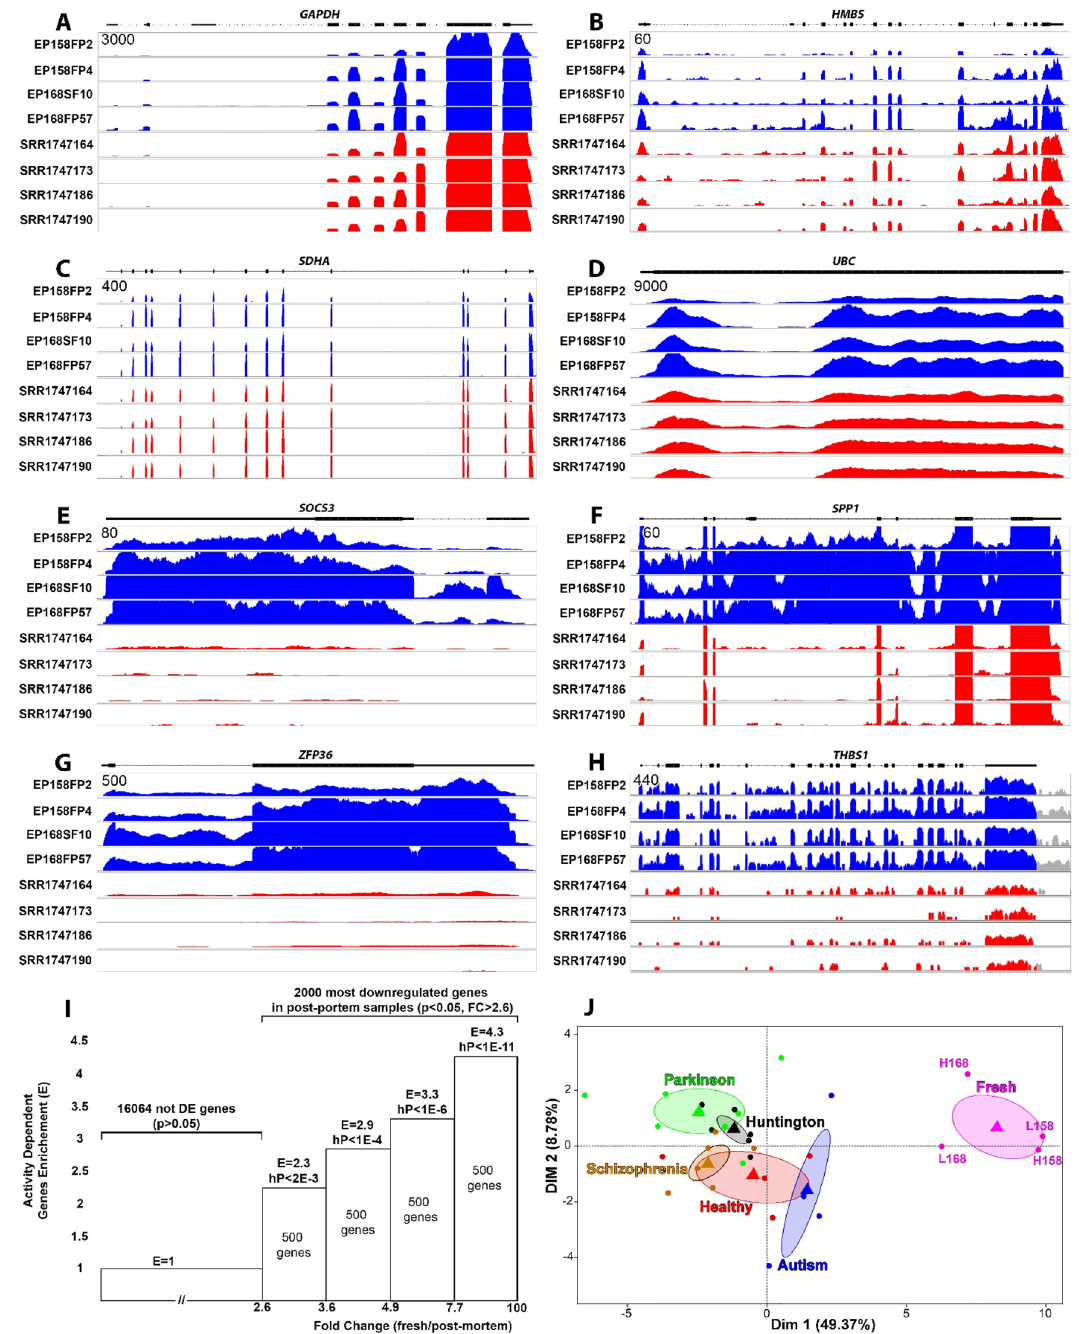
Figure 2. Selective loss of activity-dependent genes in postmortem human brain. ( A – H ) The RNAseq-derived gene expression coverage from four fresh human cortex tissues (EP158FP2, EP158FP4, EP168SF10 and EP168FP57) are shown in blue and compared to healthy postmortem cortex samples (SRR1747164, SRR1747173, SRR1747186 and SRR1747190) shown in red. While housekeeping genes including GAPDH , HMBS , SDHA and UBC appear relatively unaffected, the activity-dependent genes SOCS3 , SPP1 , ZFP36 and THBS1 showed a significant reduction in exon-specific transcript levels in postmortem samples (p < 0.05). For each gene, the y-axis is the same for each sample with the scale in the upper left corner. ( I ) We cross-referenced 2000 of the most downregulated genes in postmortem samples compared to fresh samples and ordered them based on their fold change (expression of the gene in fresh tissue/ expression of the gene in postmortem sample) into four groups of 500 genes each. For each group, we computed the enrichment in activity-dependent genes. The hypergeometric analysis of the distribution of activity-dependent genes shows their expression is significantly reduced, more than four times what is expected by chance in the 500 most downregulated genes of the postmortem samples, E Enrichment, hP hypergeometric p-value. ( J ) A PCA of the 500 activity-dependent genes with the greatest decrease in expression in the postmortem samples highly separated all the fresh tissues samples from the postmortem samples, independent of the degree of epileptic activity. Each dot corresponds to a given sample, the barycenters are represented by triangles and the ellipses show the 80% confidence interval for the position of the barycenter. L158, L168, H158, H168 correspond to the four fresh samples from patient EP158 and EP168, ‘L’ corresponds to low activity brain regions and ‘H’ corresponds to the high activity brain